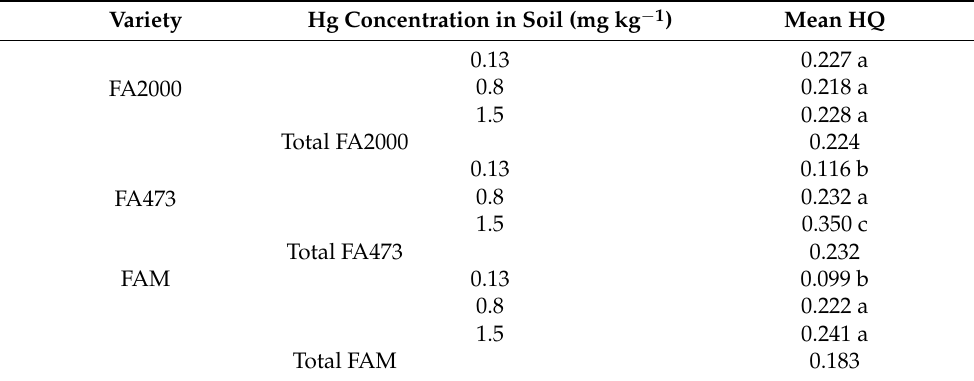
Table 3. HQ values for the different study